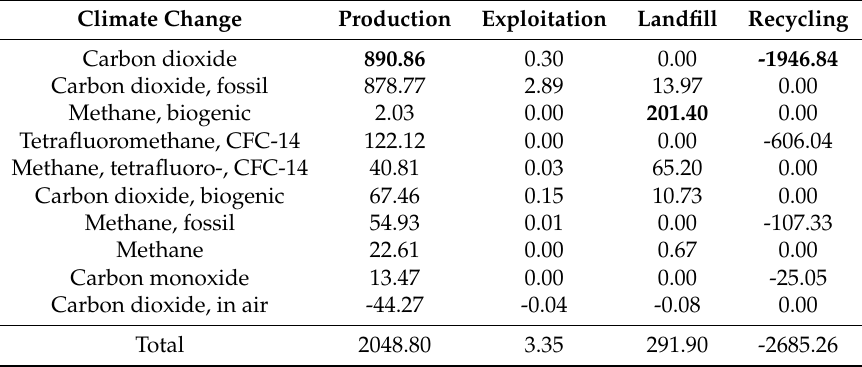
Table 7. Results of grouping and weighting of environmental after-e ff ects for compounds causing climate change, occurring in the 1 megawatt photovoltaic power plant [unit: Pt].